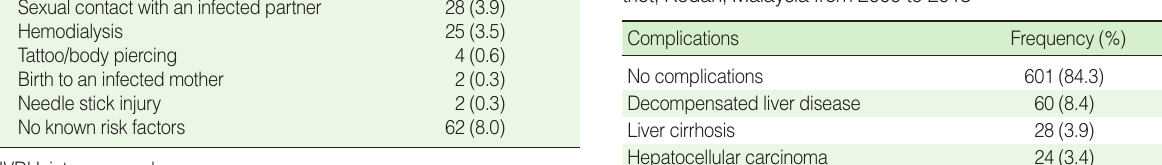
Table 3. Complications of hepatitis C infection in the Kota Setar dis- trict, Kedah, Malaysia from 2009 to 2013